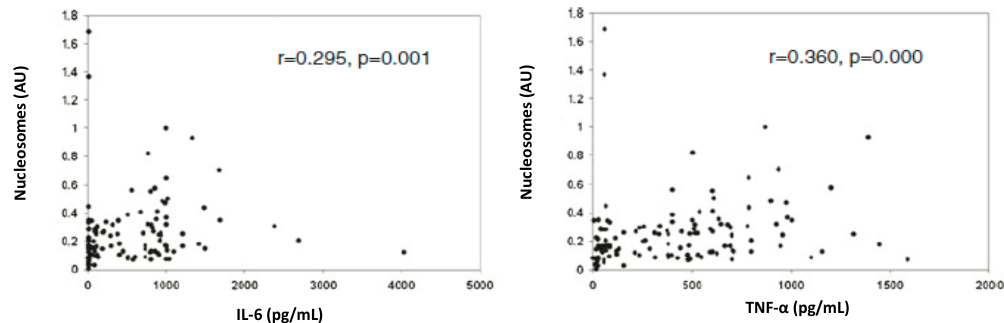
Figure 13. Positive correlation between serum cfCh levels and inflammatory cytokines (IL-6 and TNF- α ). The study included 140 healthy subjects aged 15–70 years. cfCh levels were measured using the Cell Death Detection ELISAPlus kit (Roche Applied Sciences, Mannheim, Germany). Results are expressed in arbitrary units (AU). IL-6 and TNF- α were measured using cytometric bead array assay kit (BD Biosciences, San Jose, CA, USA). Reproduced from [62].